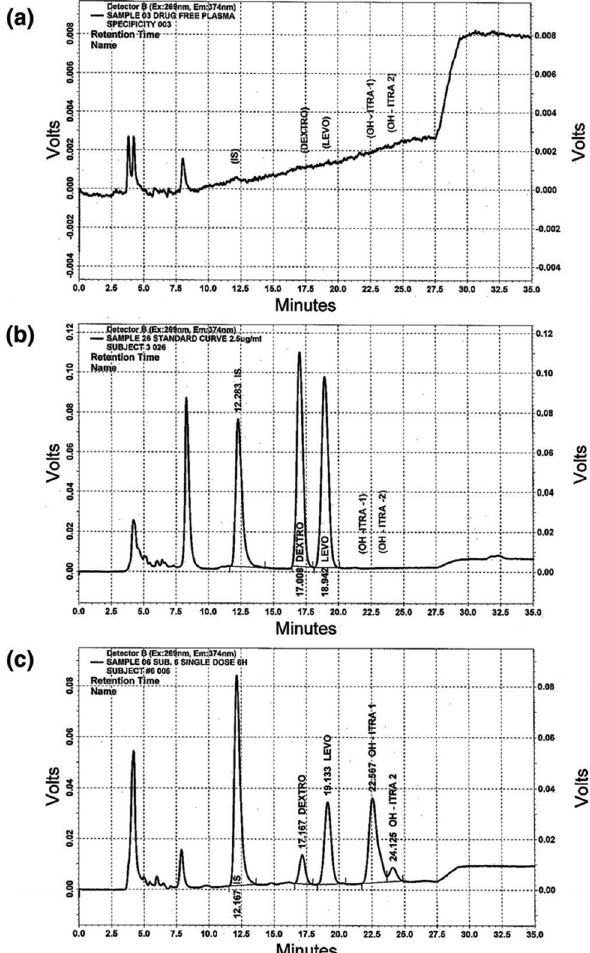
Figure 1: HPLC chromatograms: ( a ) drug - free plasma, ( b ) plasma sample spiked with itraconazole at 2.5 µg/mL, ( c ) human plasma sample collected 6 h after the administration of a 200 mg dose of itraconazole. Reprinted from ref. [ 43 ]